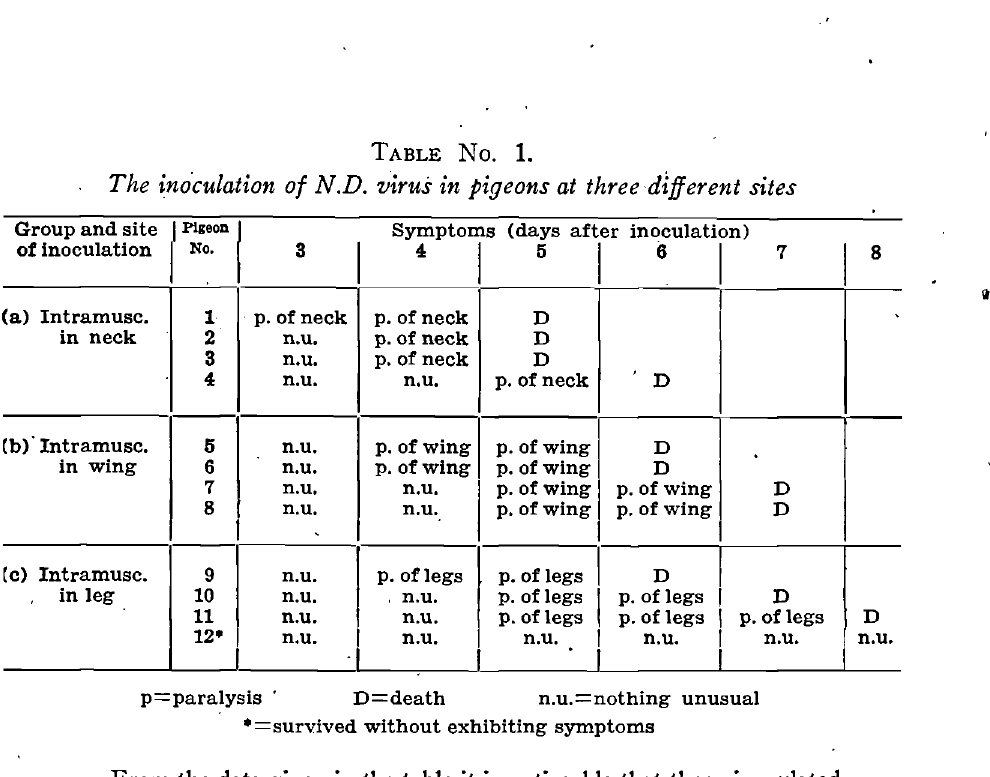
The ino'culation of N.D. virus in pigeons at threedijjerent sites ,Pigeon! I Group and site of inoculation